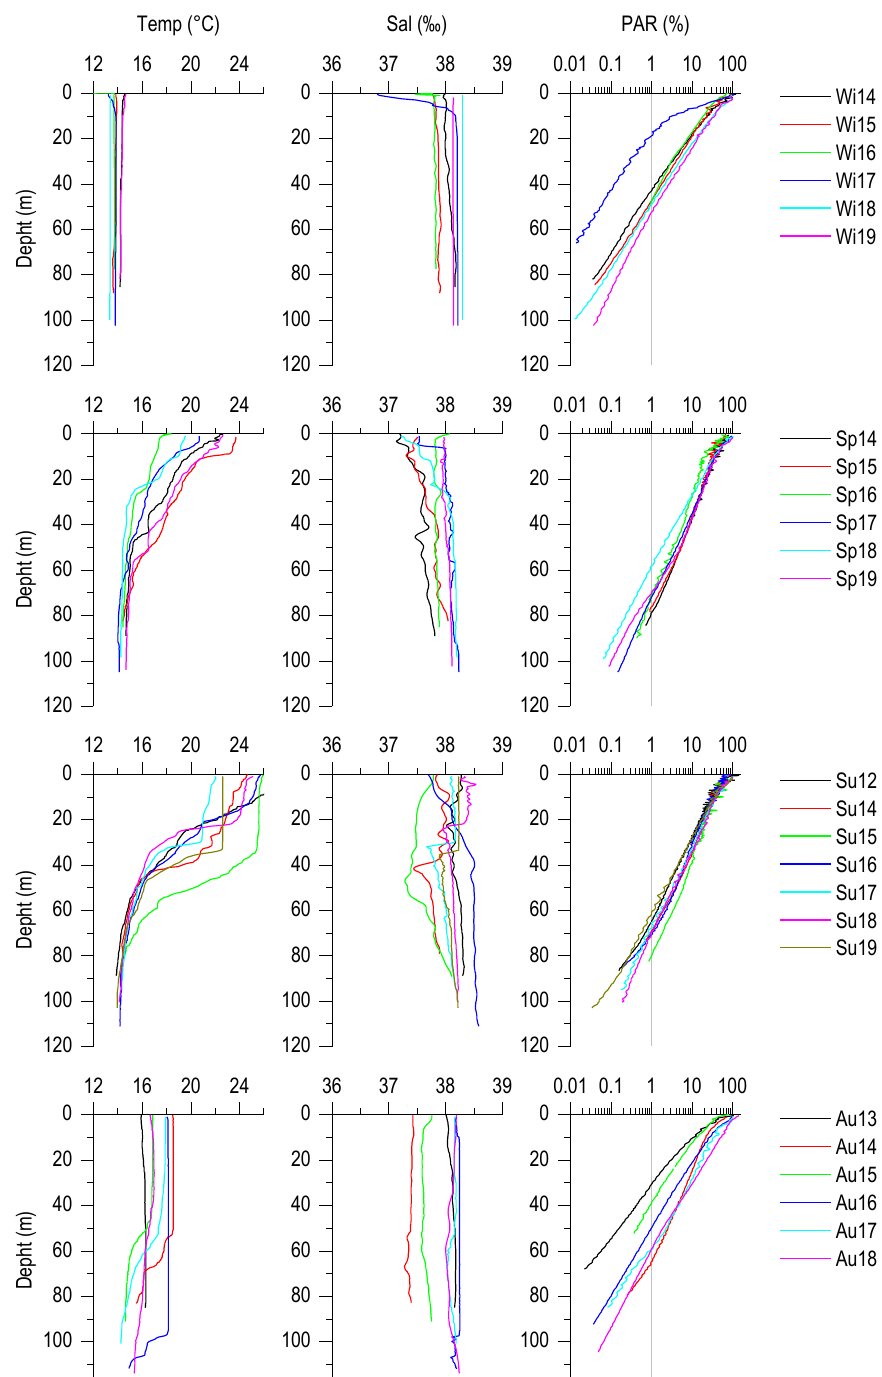
Figure 2. Seasonal (winter: Wi; spring: Sp; summer: Su; autumn: Au) profiles of temperature (°C), salinity (‰) and PAR (%) in the different years.